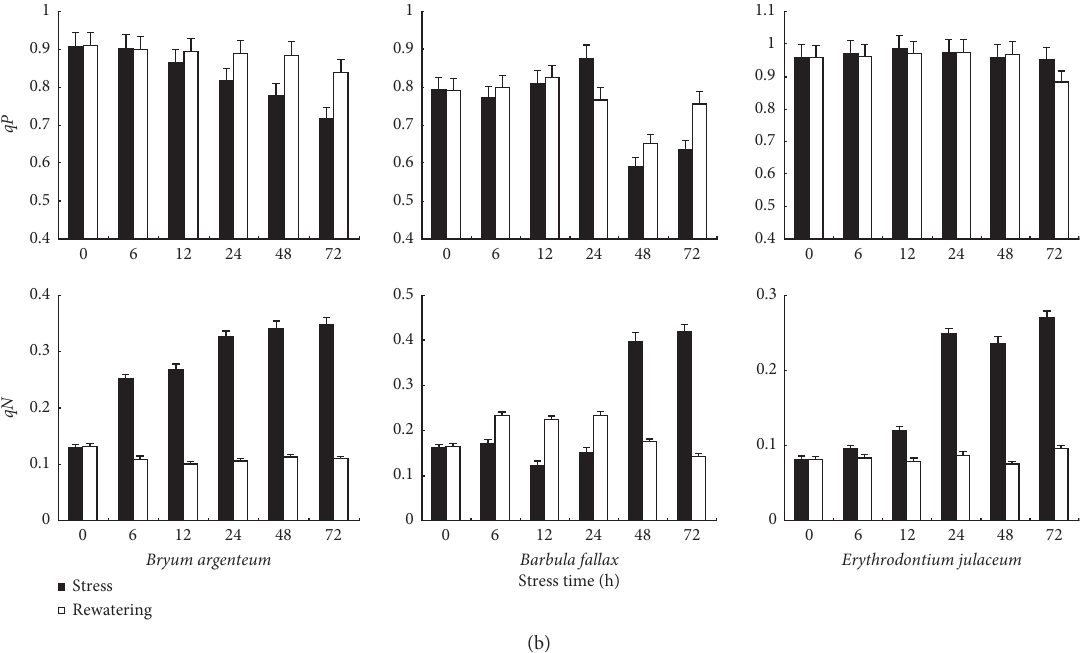
Figure 4: The effect of replenishment and drought stress on chlorophyll fluorescence parameters in three epilithic mosses. Erythrodontium julaceum with permission from [24]. Copyright 2016 open-access from Bangladesh botanical society.